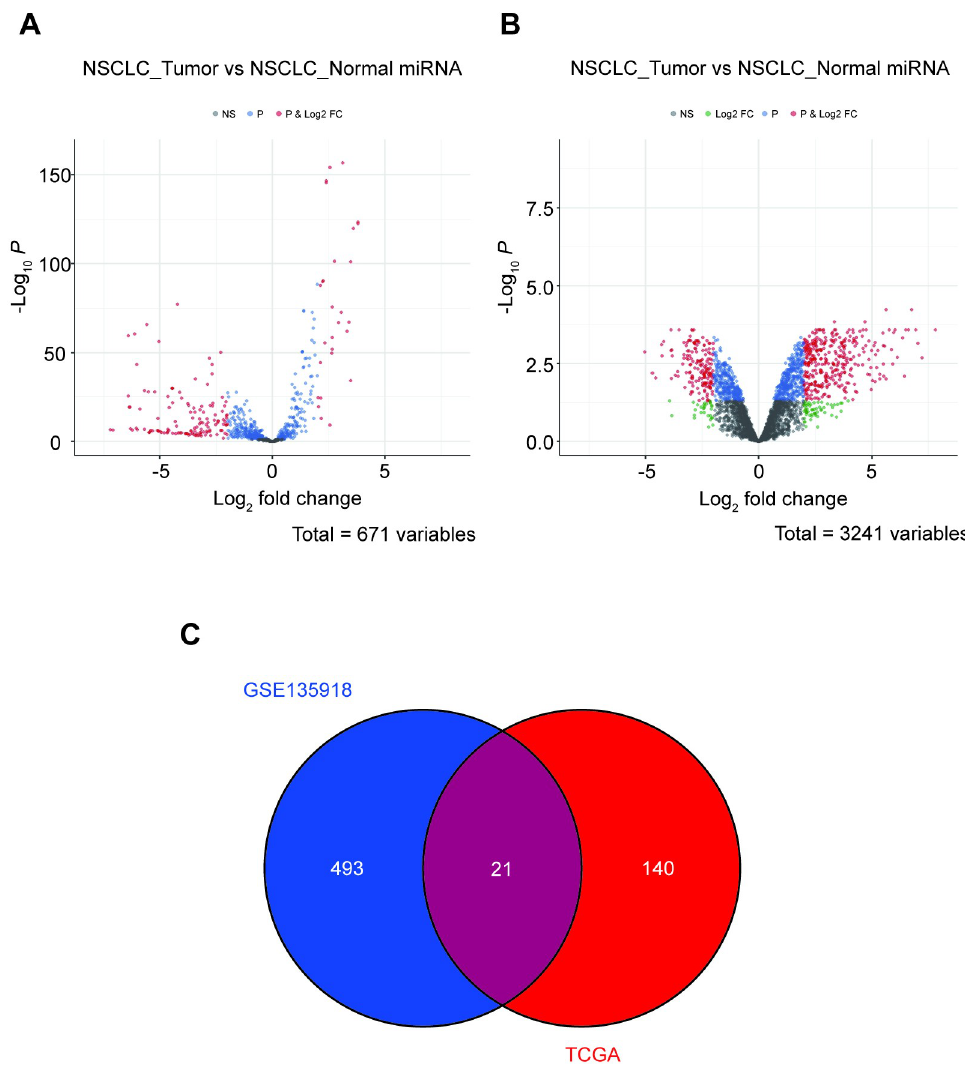
Fig 1. Screening of miRNAs shared by TCGA database and GEO database. A: The volcano map of miRNAs differentially expressed in NSCLC screened under the TCGA database. (P > 0.05). B: Screening differentially expressed miRNA volcano maps in NSCLC under the GSE135918 database (p > 0.05). The red dots on the volcano map represent differential miRNAs. C: Venn diagram of intersection of TCGA and GSE135918, the numbers represent the number of